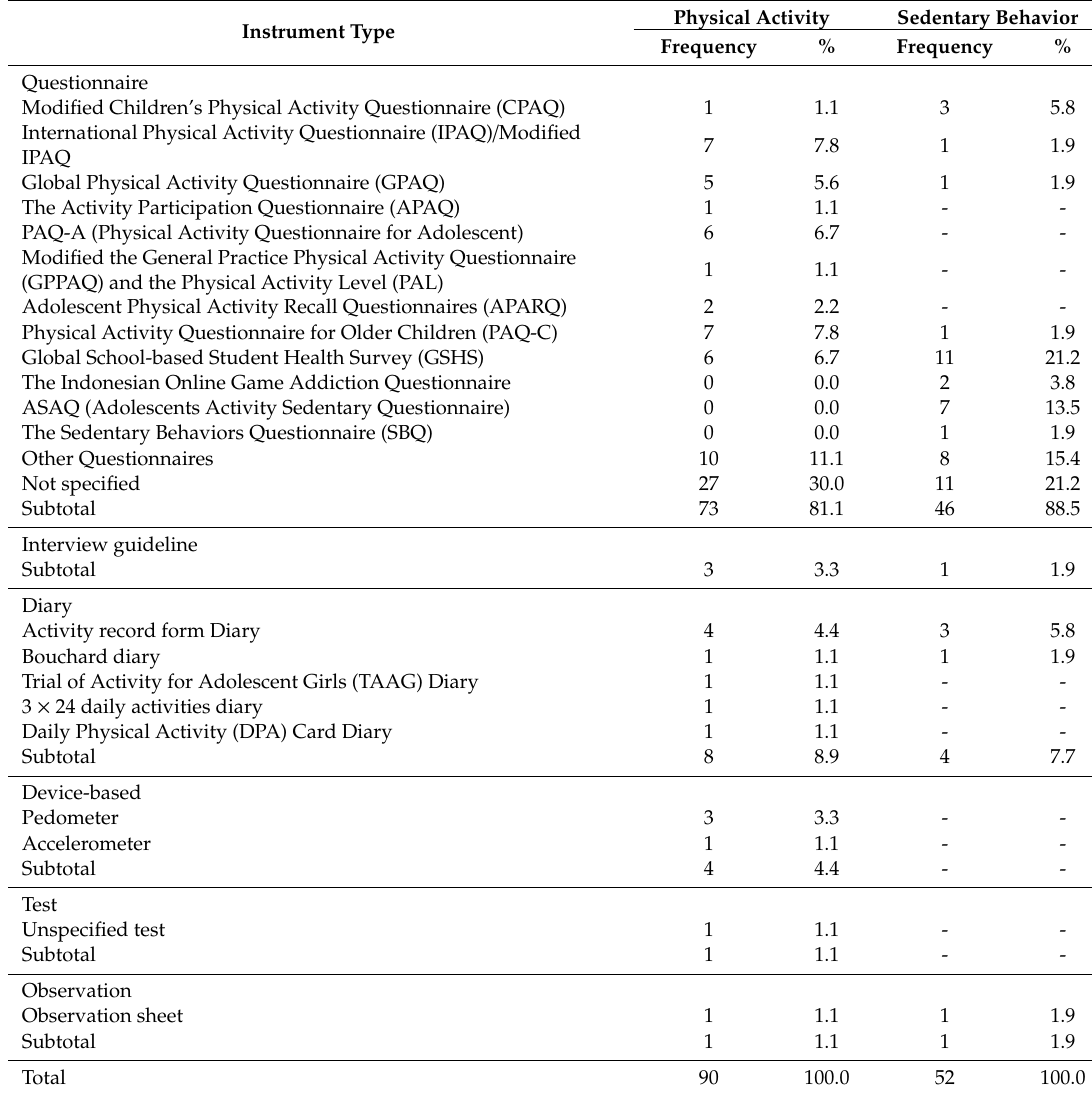
Table 3. Instruments for measuring physical activity and sedentary